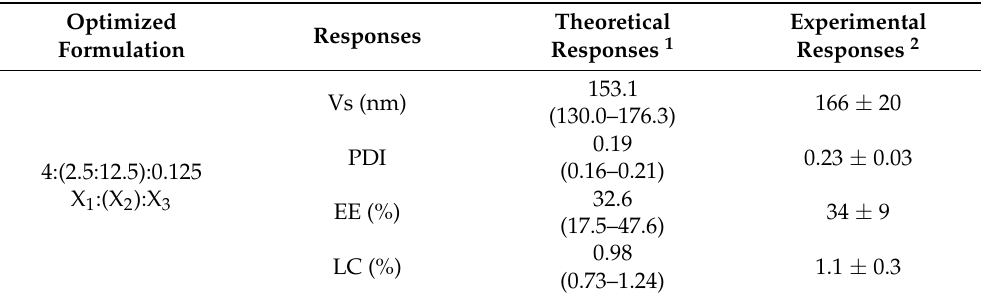
Table 4. Factors and theoretical responses predicted for the optimized transfersomes, including the responses obtained in the experimental